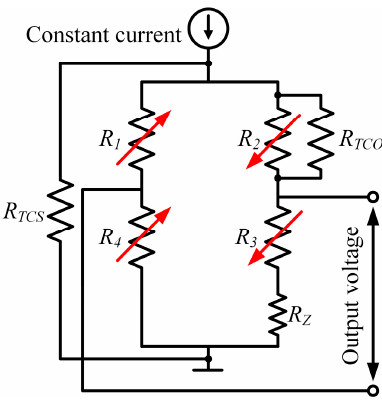
Figure 9. Schematic diagram of the compensation by resistors.